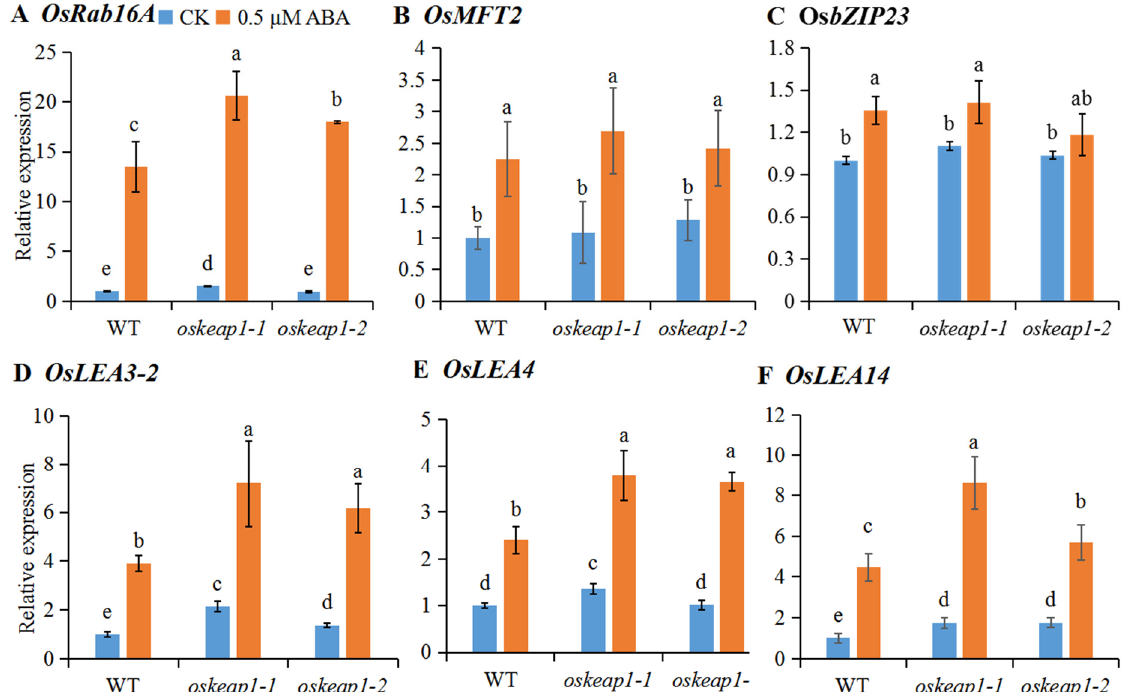
Figure 5. Relative expressions of the ABA response genes and their regulators in germinating seeds that had been germinating for 4 days on a 0.5 MS medium without abscisic acid (ABA) (CK) or with 0.5 µ M ABA. The expression levels of the same gene in different materials were compared with the wild-type (WT) germinated without ABA (its level was set as 1). OsACTIN was used as an internal reference. Data are shown as the mean ± standard error of three biological repeats. One-way ANOVA was performed for the statistical analysis, where different letters represent significant differences ( p ≤ 0.05).